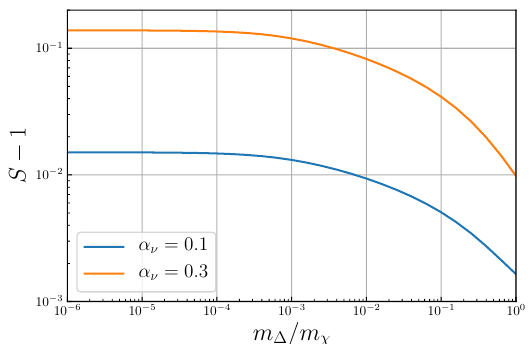
Figure 5 . The Sommerfeld enhancement factor S in the s -channel case as a function of m ∆ which is defined by m 2 ≡ m 2 − m 2 χ φ ∆